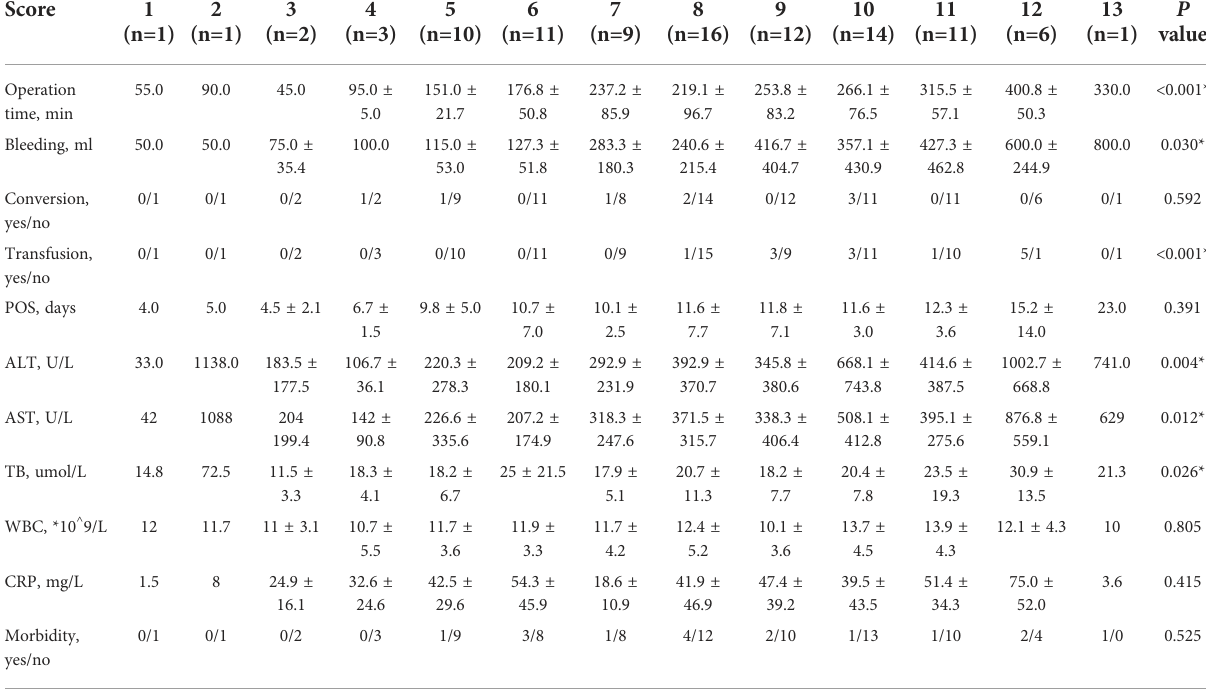
TABLE 3 Surgical outcomes according to the novel dif fi culty rating system